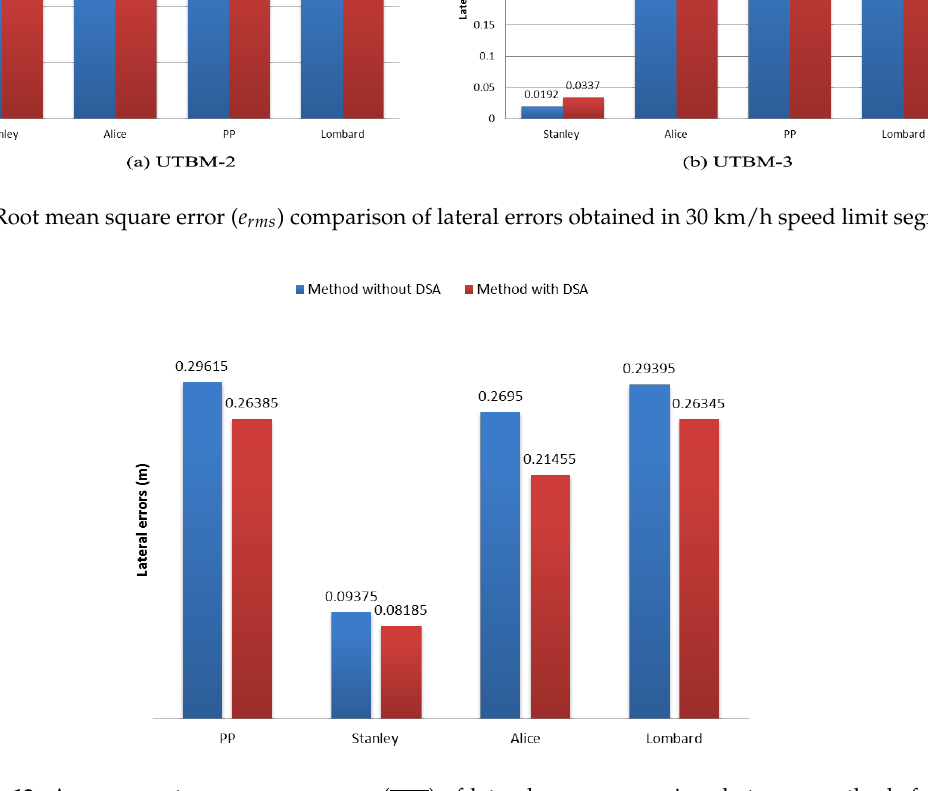
Figure 13. Average root mean square error ( e rms ) of lateral error comparison between methods for 30 km/h speed limit segments.